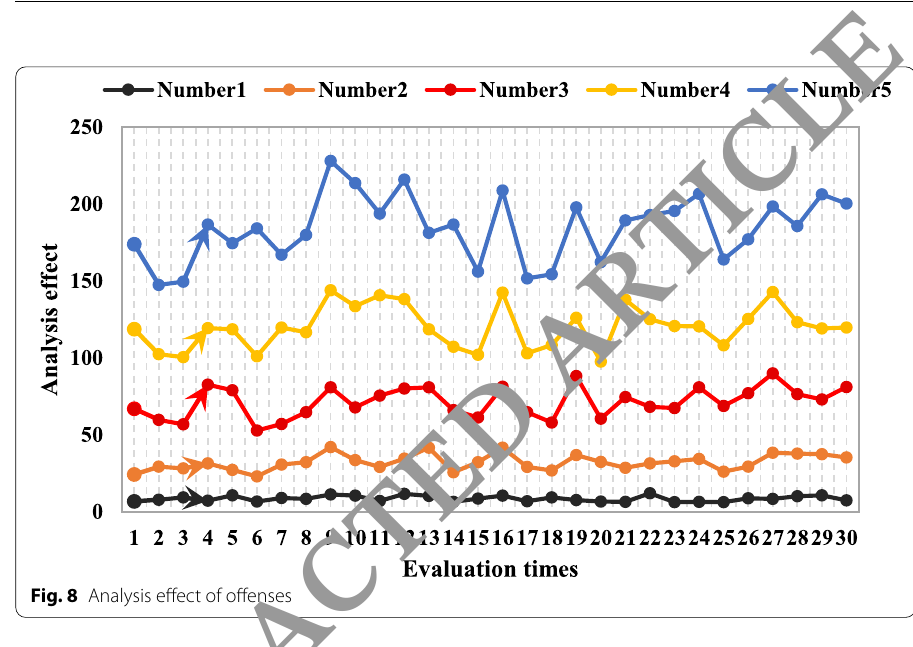
Fig. 8 Analysis effect of